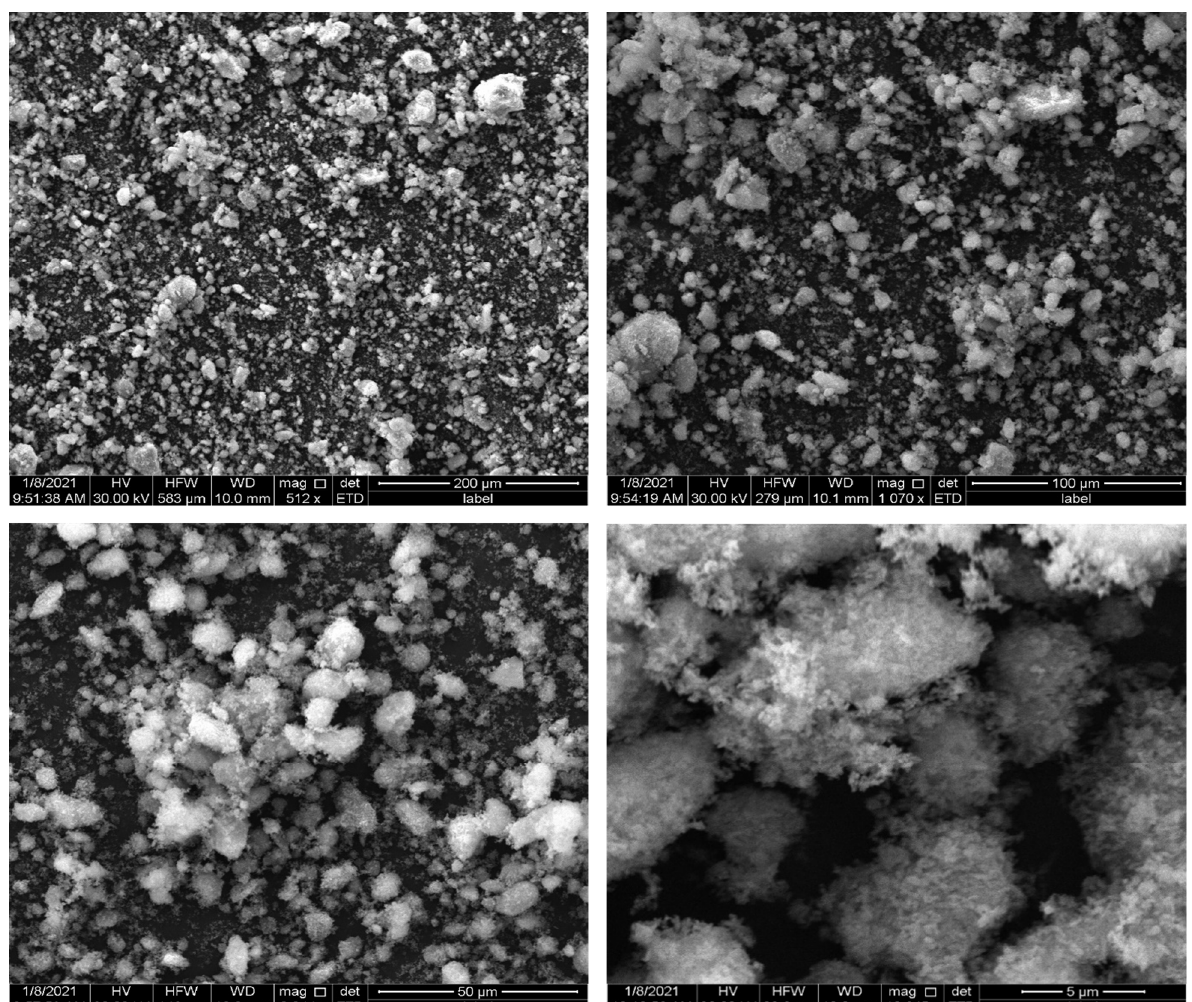
Figure 4. SEM images of biosynthesized ZnO NPs.